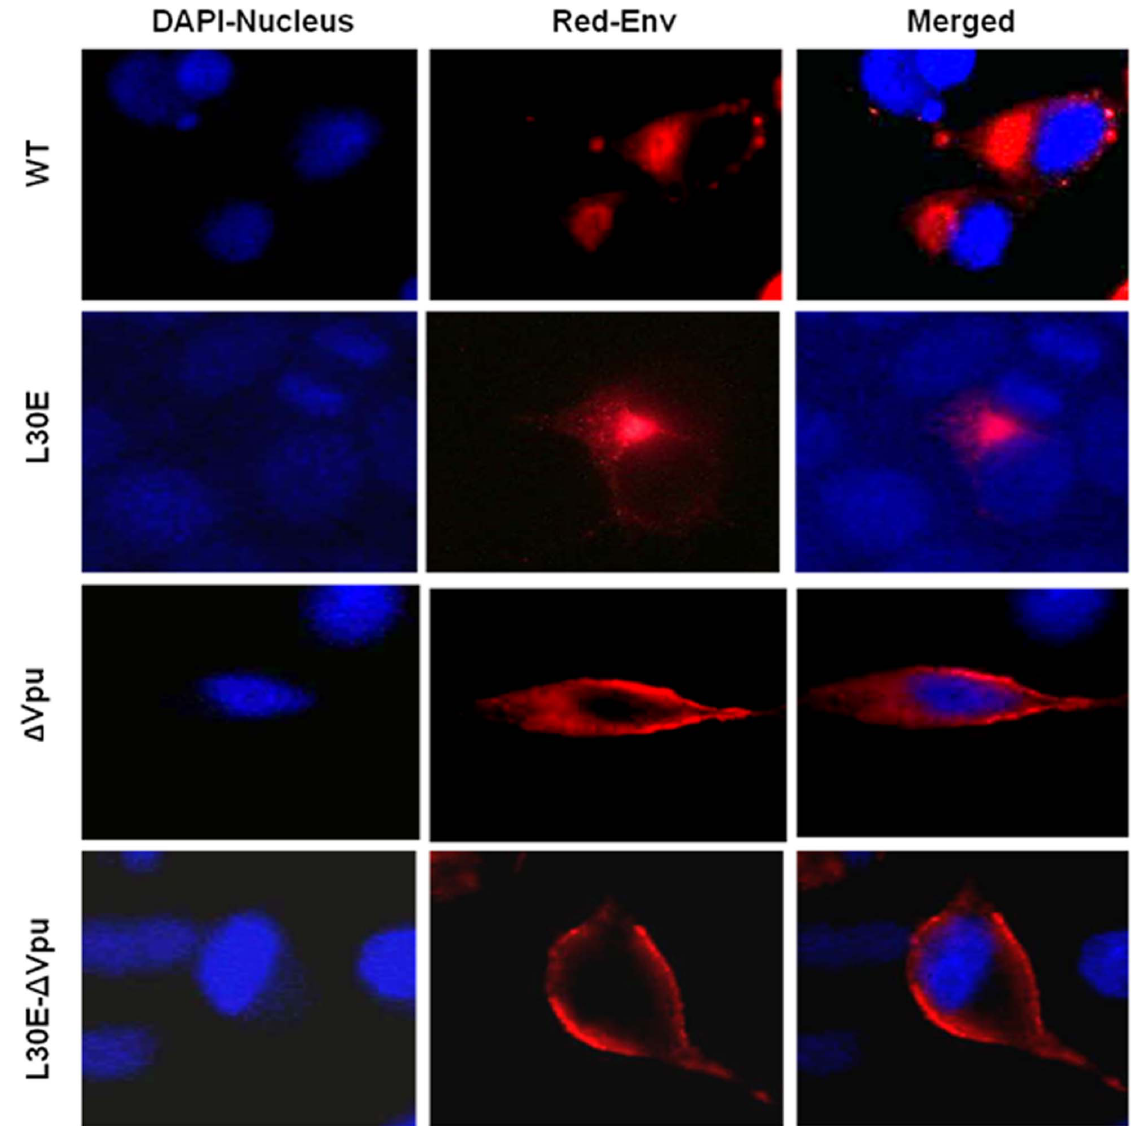
Figure 7. Vpu inactivation affected distribution of Env in HeLa cells. HeLa cells were transfected with WT and mutant plasmids (L30E, D Vpu, L30E- D Vpu). At 24 h post-transfection, cells were washed, fixed, permeabilized and immunolabeled with anti-Env antibody, 2F5. Nuclei were stained using ProLong Anti-fade DAPI (Molecular Probes, Invitrogen). Cells were visualized using Olympus IX51 microscope at 60X oil immersion objective. Scale bar: 10 m